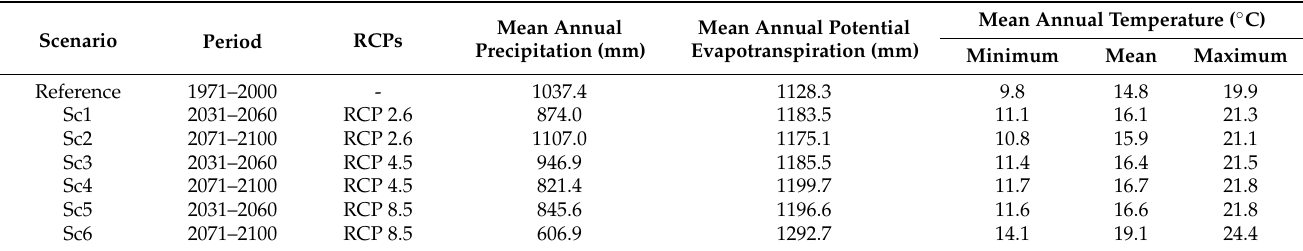
Table 2. Climate change scenarios